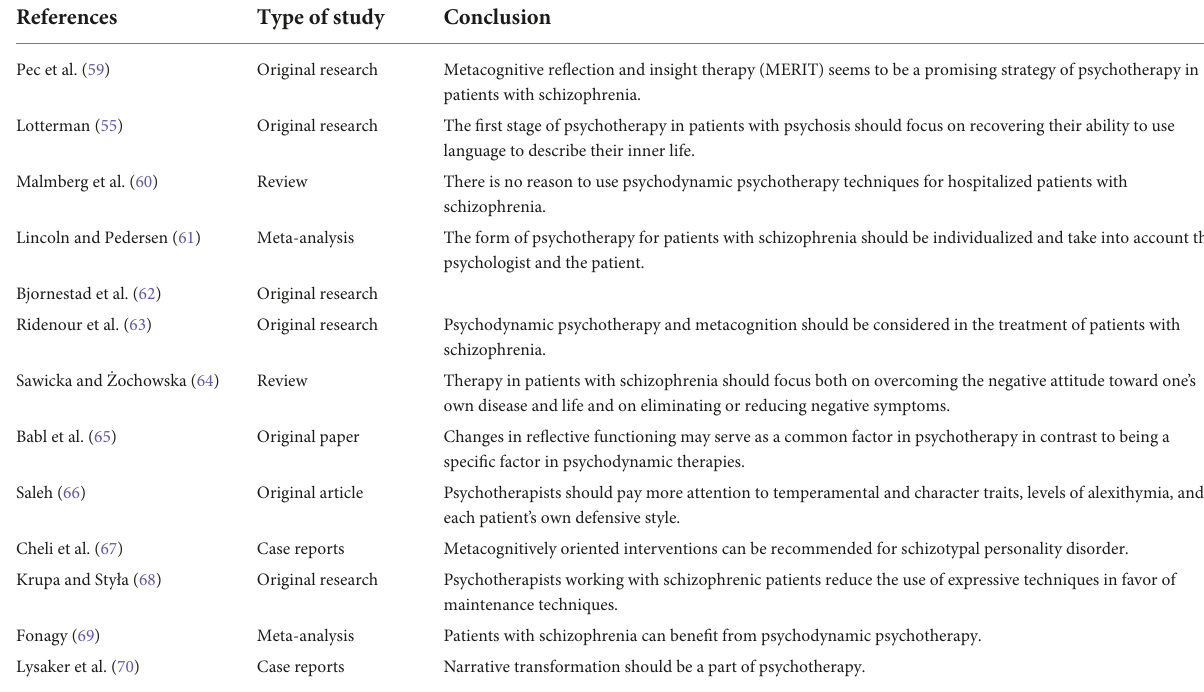
TABLE 7 Studies about psychotherapy in